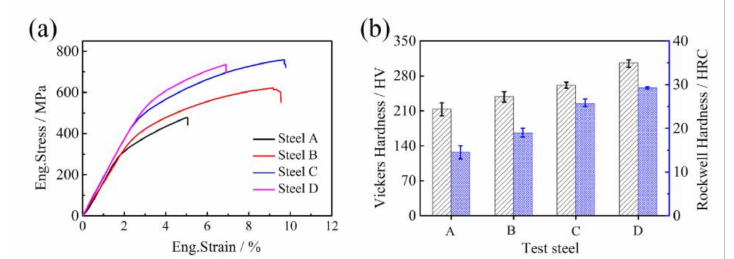
Figure 7. ( a ) Engineering strain–stress curve of the cast test steels; ( b ) Vickers and Rockwell hardness of cast steel with different (NbTi)C